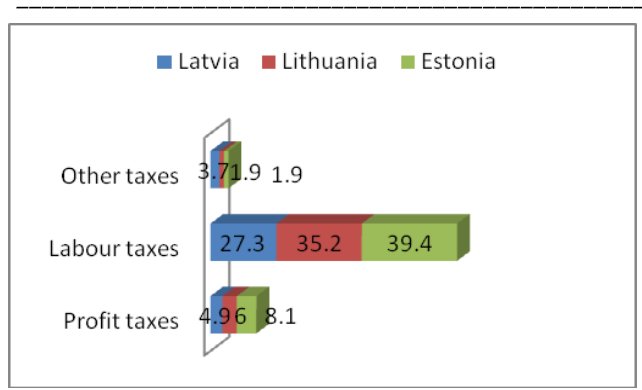
Fig. 3. Total tax rate, percentage in the Baltic States (Source: Paying Taxes 2014: the global picture – a comparison of tax systems in 189 economies worldwide).